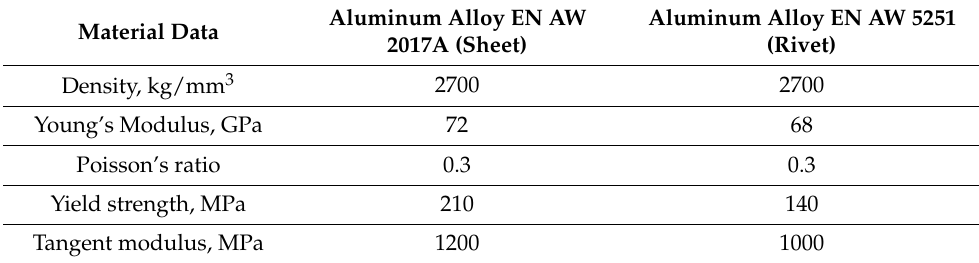
Figure 4. Stress–strain curve of the bilinear material model for sheets and a rivet. Table 3. Material properties of the bilinear material model. Table 3. Material properties of the bilinear material